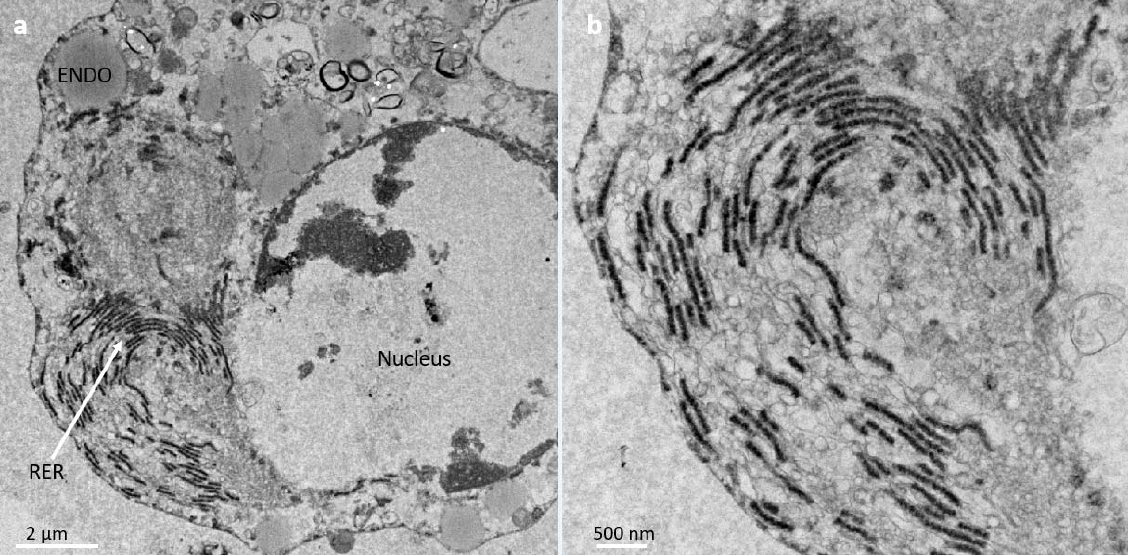
Figure 10. ( a ) Transmission electron micrograph of a large granular BmVIII ‐ SCC cell on day 85 of culture in a bioreactor with gelatinous beads showing perinuclear strands of rough endoplasmic reticulum (RER) within the cytoplasm and membrane ‐ bound vesicles (ENDO), with disrupted nuclear membrane (NM). ( b ) Organized RER showing multiple small vesicles.